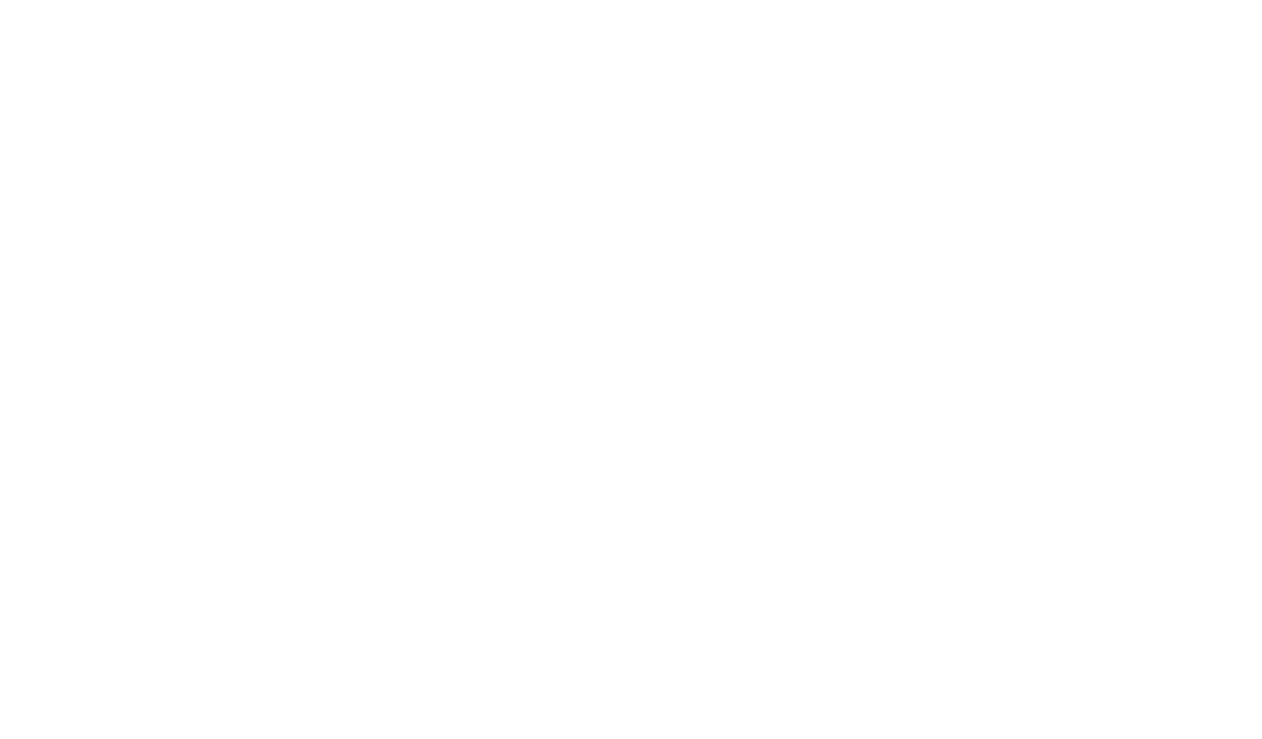
Frontiers in Microbiology | Terrestrial Microbiology July 2013 | Volume 4 | Article 181 |